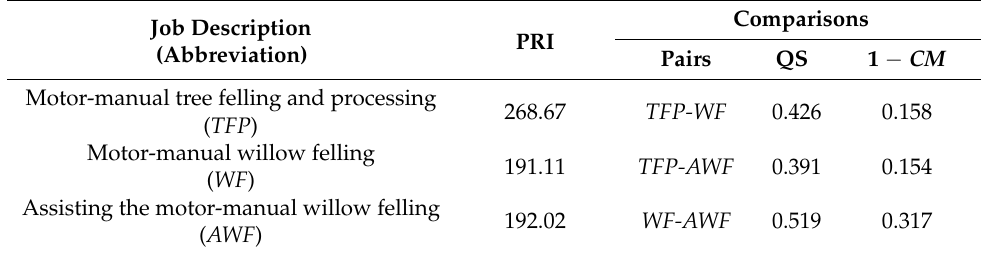
Table 3. Results of comparison for the case study